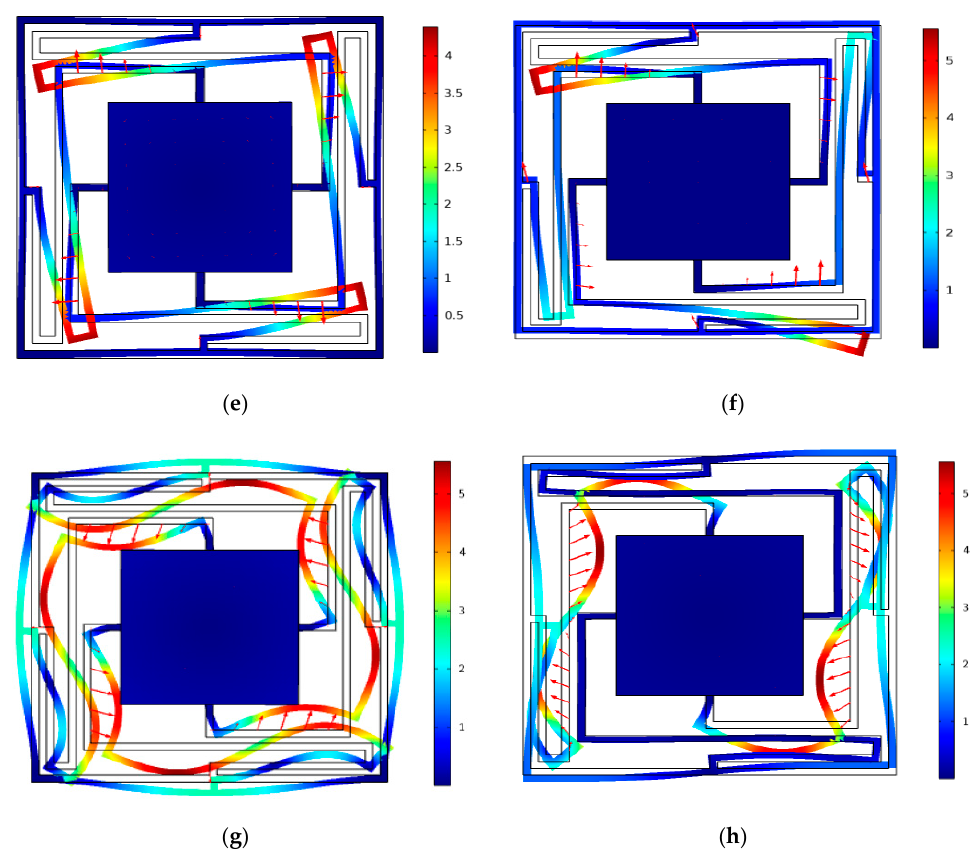
Figure 3. The vibration modes and displacement vector fields of the corresponding point in BGs of the proposed PC structure. (a) (b) (c) (d) (e) (f) (g) (h).